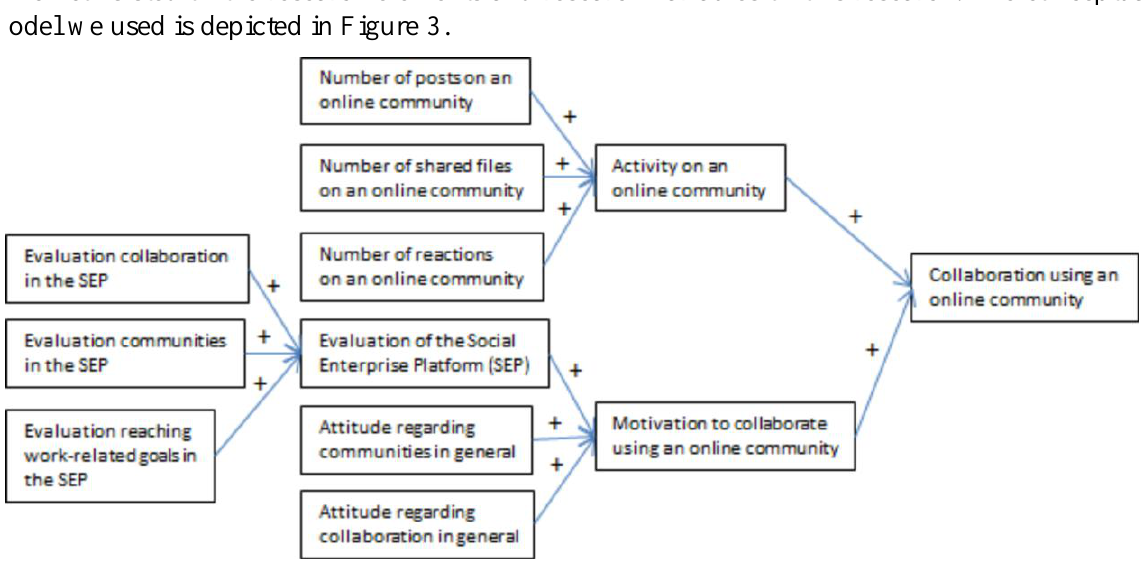
Figure 3. Conceptual